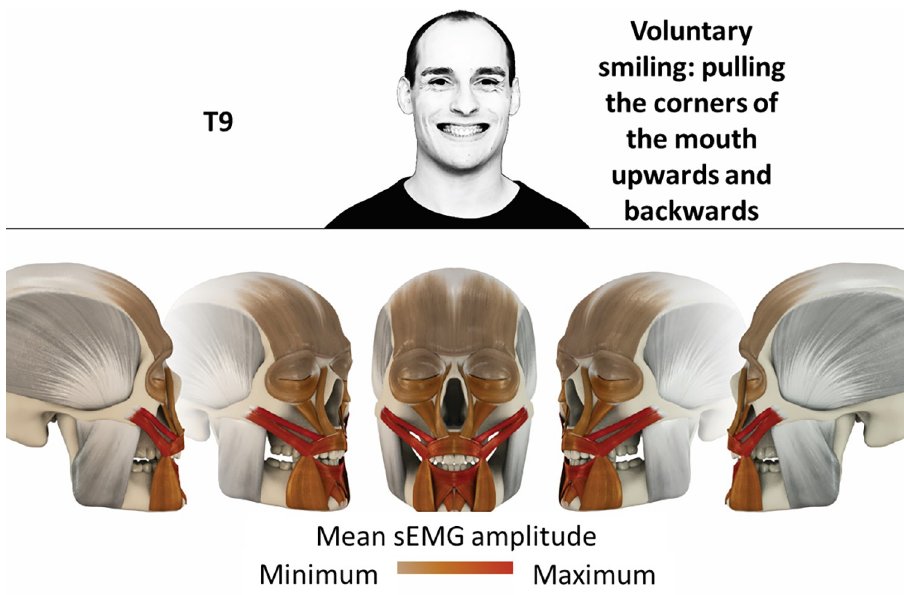
Fig 10. Color-coded facial muscle activation pattern of task T9. Voluntary smiling: Pulling corners of the mouth upwards and backwards. Animation by Jonas Laustro¨er.